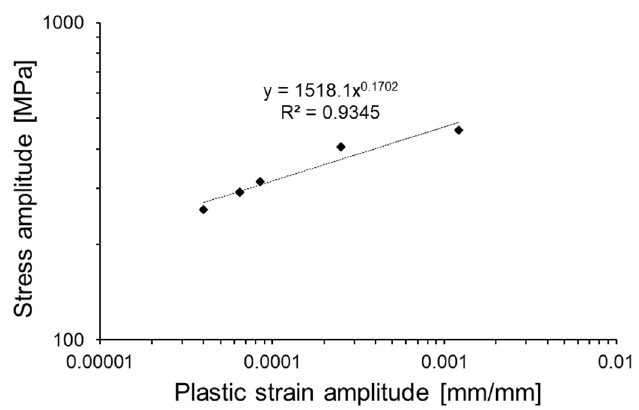
Figure 7. Stress amplitude versus plastic strain amplitude of stabilized hysteresis loops in log–log coordinates.